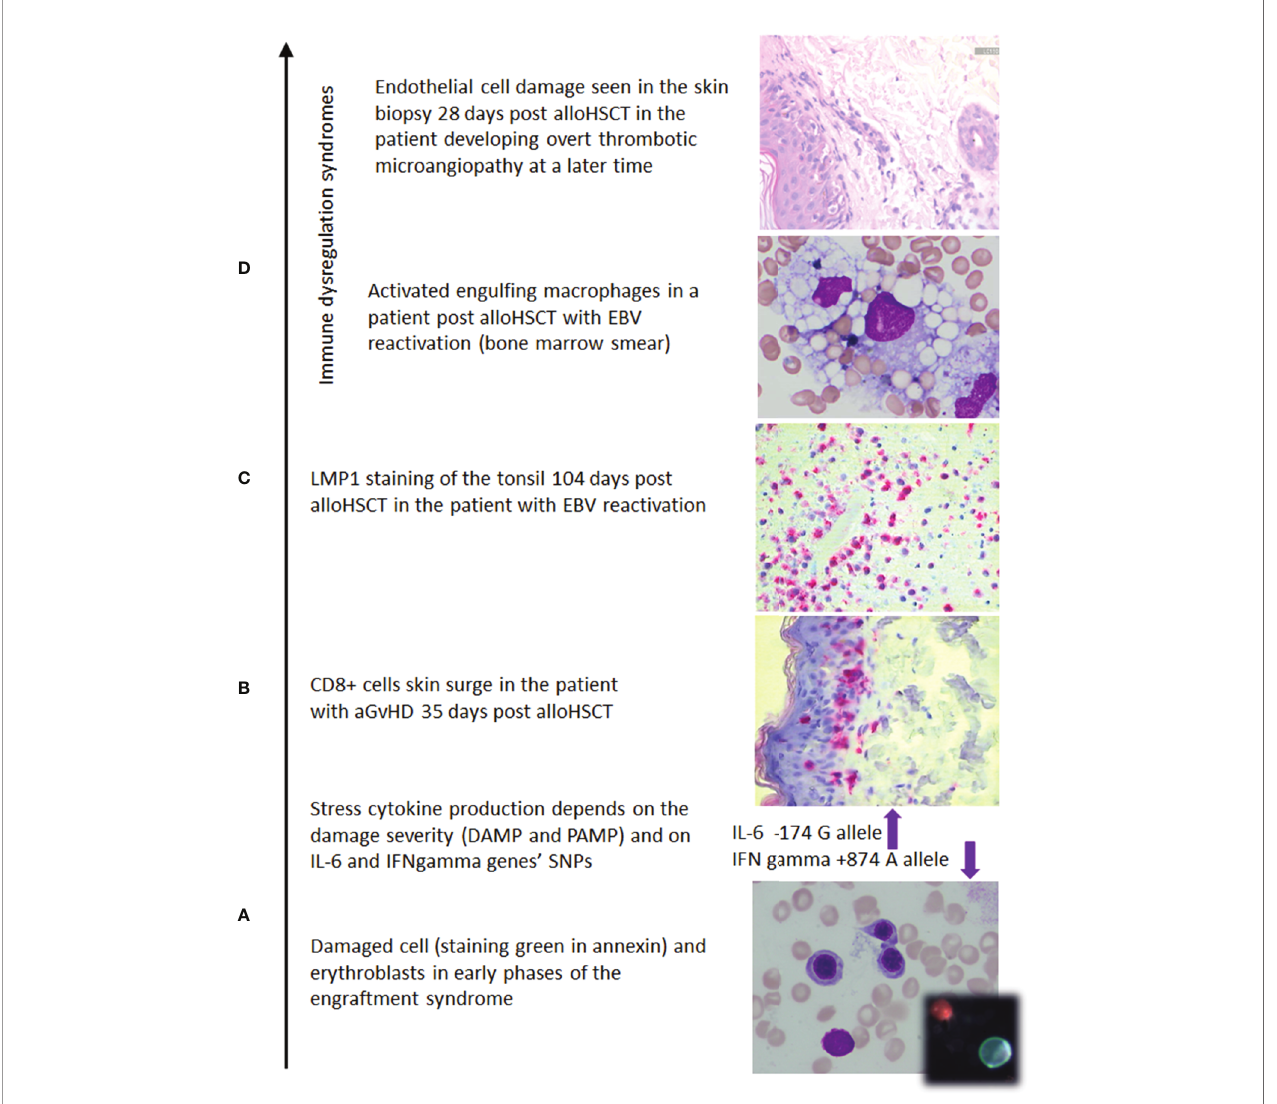
FIGURE 2 | The photos illustrate (own documentation): (A) damage of the marrow which induces IL-6 and release of other stress cytokines whose level is modi fi ed by SNP polymorphic features (14, 24, 25, 112, 113), (B) skin biopsy with CD8+ cell epithelium colonization in aGvHD case (114), (C) EBV reactivation documented on 104 th day after transplant (23), (D) macrophages in a patient with hemophagocytic syndrome, the skin biopsy documenting early endothelial cell damage in the patient developing overt thrombotic microangiopathy at a later